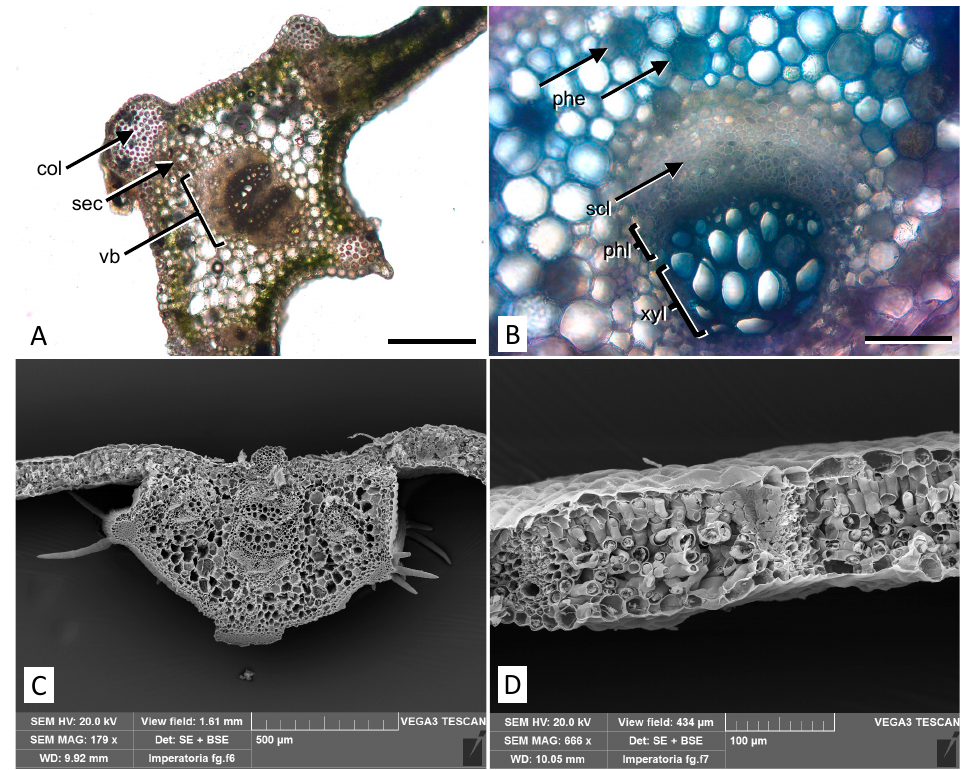
Figure 2. Micromorphological features of the P. ostruthium leaf. ( A ) Light microscopy view of a cross section at the midvein level with collenchyma protrusions. col: collenchyma; sec: secretory channel; vb: vascular bundle. Bar 500 µm. ( B ) Detail of a vascular bundle after staining with TBO: around the bundle, several parenchymatous cells rich in polyphenols appear blue/green (phe). scl: sclerenchyma; phl: phloem; xyl: xylem. Bar 200 µm. ( C ) SEM micrograph of a cross section at the midvein level showing typical trichomes located on the collenchyma protrusions. ( D ) SEM view of a leaf cross section showing the mesophyll structure.